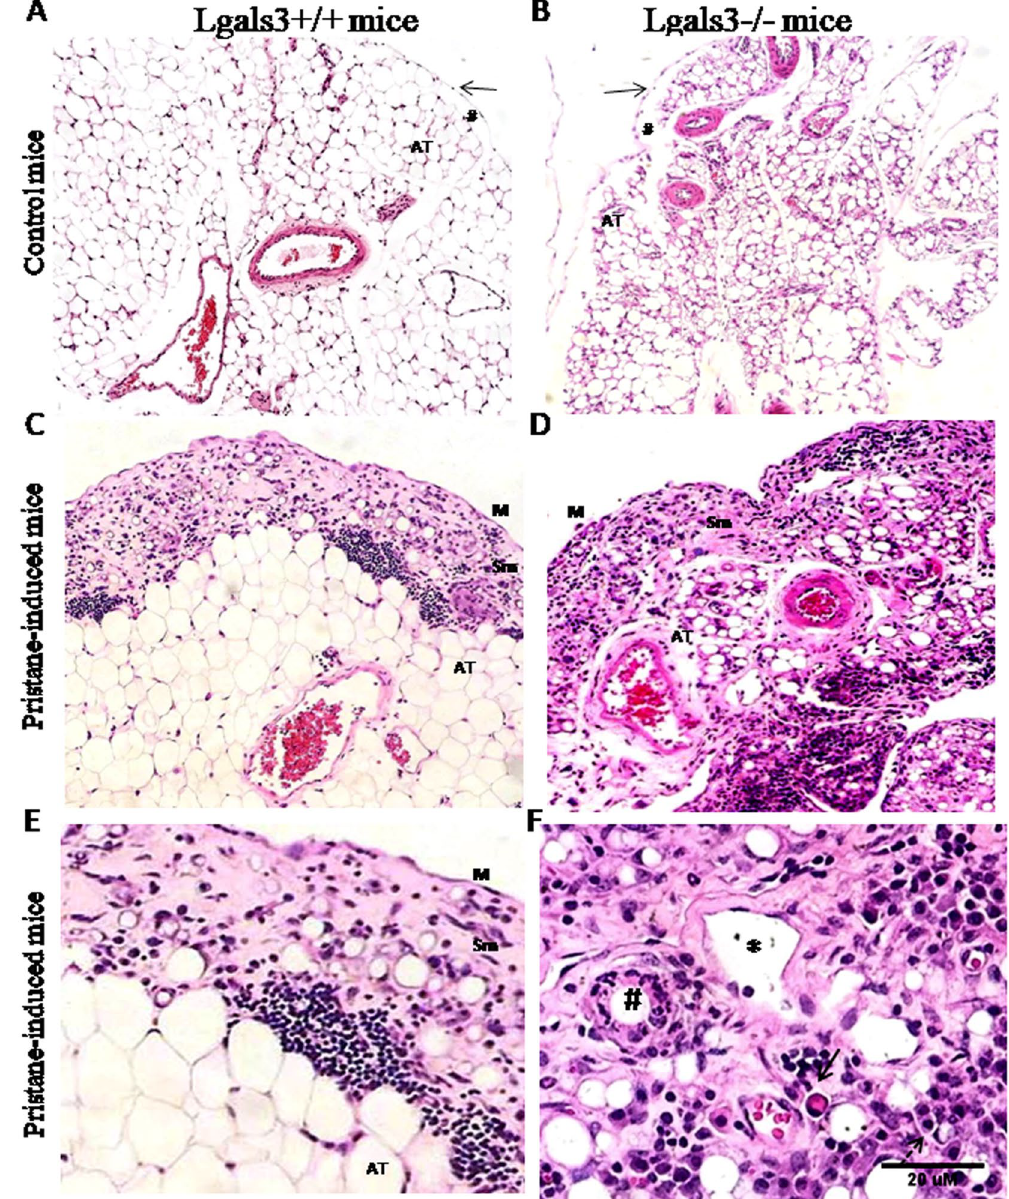
Figure 1. Photomicrographs of mesentery on pristane-induced mice. Representative images of mesenteric tissues obtained from control Lgals3 + / + ( A ) and Lgals3 − / − mice ( B ). Pristane induced submesothelial inflammatory reaction in Lgals3 + / + mice ( C ) and diffuse in the absence of galectin-3 ( D ). M: mesothelium, Sm: submesothelium, and AT: adipose tissue. ( E ) Milky spot-like structures were observed in the submesothelial tissue of pristane-induced Lgals3 + / + mice. In Lgals3 − / − , clusters of lymphocytes were disorganized showing atypical plasma cells (bold arrow), lymphatic dilation ( * ), myeloid reaction to lipid-stored area (#) and LE cells- like ( F ). Data are representative of three independent experiments. Magnification: A-D (100 × ) and E-F (500 ×